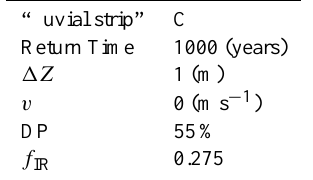
Table 4. Data used to characterize the magnitude of the natural event and the resulting damage probability (DP) and factor of in- crement of the risk ( f IR ) for the case study considered.